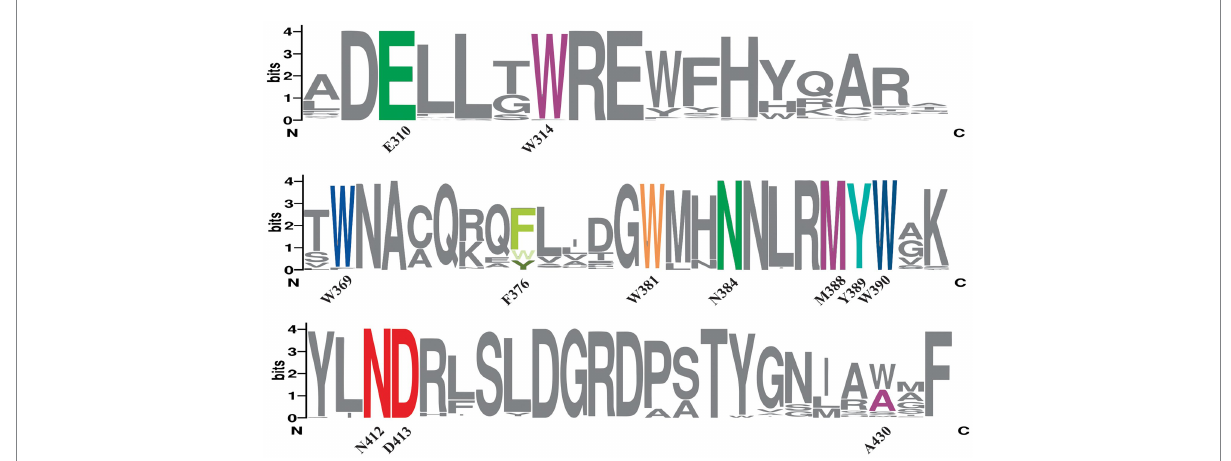
FIGURE 2 Sequence conservation of predicted bifunctional CPD/(6-4) PHRs. MSA from predicted bifunctional photolyases was used to create a sequence alignment Logo showing the conservation of amino acids involved in electron transfer (Y389-W369-W390-F376-W381, in the same colors as phylogeny rings from Figure 1), FAD binding (N412, D413 in red), lesion binding (W314, A430, M388 in purple) and lesion stabilization (E310, N384 in green). The height of each letter is proportional to the frequency of the corresponding amino acid and the overall height of each stack for a position is proportional to the sequence conservation, measured in bits. N at the left and C at the right indicate amino- and carboxyl- terminal regions. Numbers indicate amino acid position in